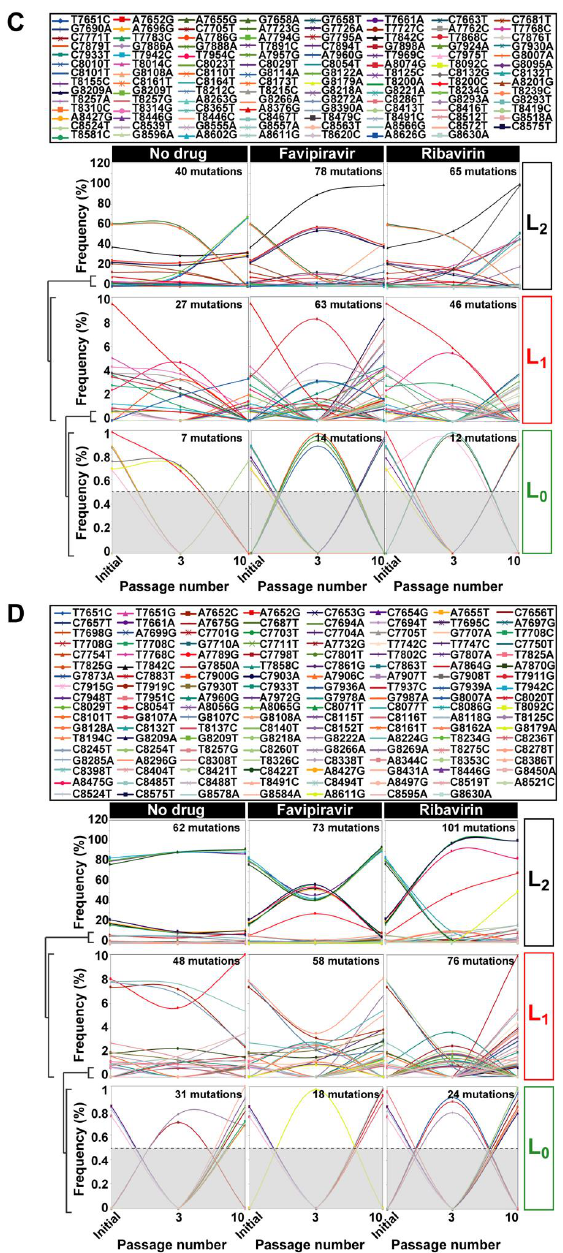
Figure 2. Mutational waves in hepatitis C virus in the presence of antiviral inhibitors. ( A ) scheme of the HCV genome, encoded proteins, and location of the amplicons used for UDS analysis; residue numbering is according to reference isolate JFH-1; ( B ) top box: mutations (color coded) that changed in frequency upon serial passage of HCV p0. The panels below show the quantification of mutant frequencies in the absence or presence of the antiviral drug, indicated at the top. The range of frequency variations has been divided into levels L 0 , L 1 , and L 2 , as shown in ordinate, and explained in the text; passage number is given in abscissa, and the total number of mutations at each level and passage condition is written inside the panel; the discontinuous horizontal line in the L 0 panels indicates the 0.5% cut-off frequency value used in these experiments; ( C ) same as ( B ) except that the populations analyzed were those derived from HCV p100; ( D ) same as ( B ) except that the populations analyzed were those from HCV p200; note the line bundles particularly visible at level L 2 . The same mutant frequency scales in ordinate are used for each virus and level, for comparative purposes. The complete list of mutations and deduced amino acid substitutions is given in Tables S3–S5 of [19]. The experimental design is depicted in Figure 1, and experimental and bioinformatics procedures are described in the